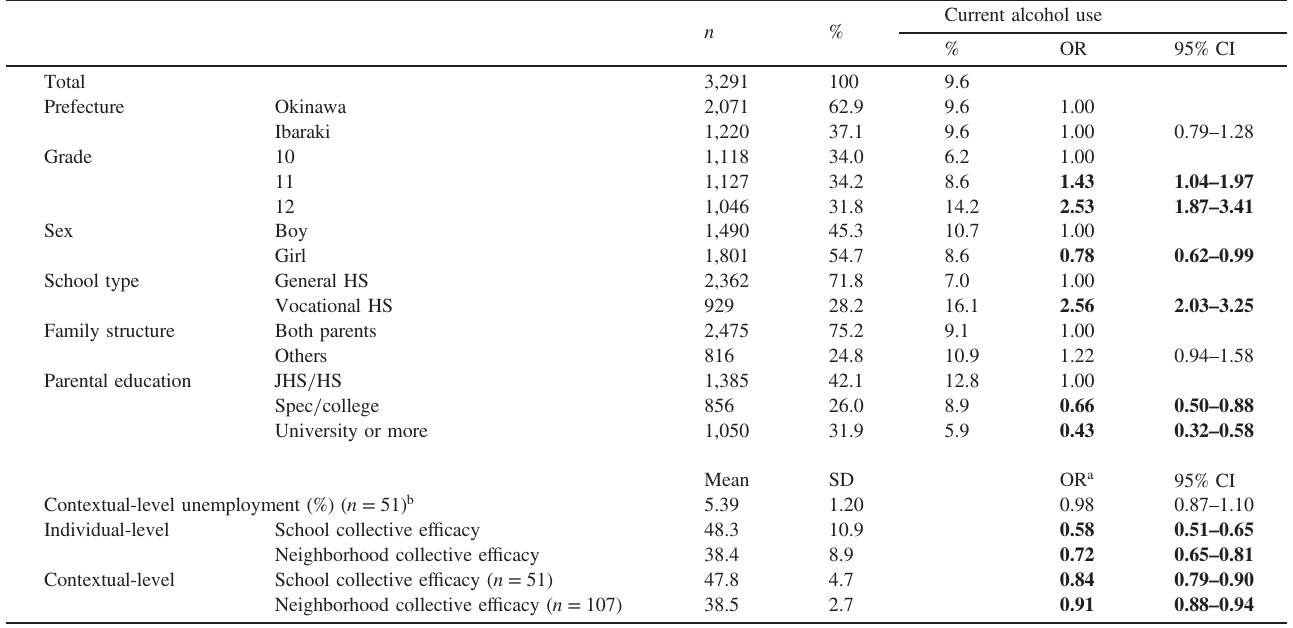
Table 1. Characteristics of demographic factors and collective e ffi cacy variables and prevalence of current alcohol use